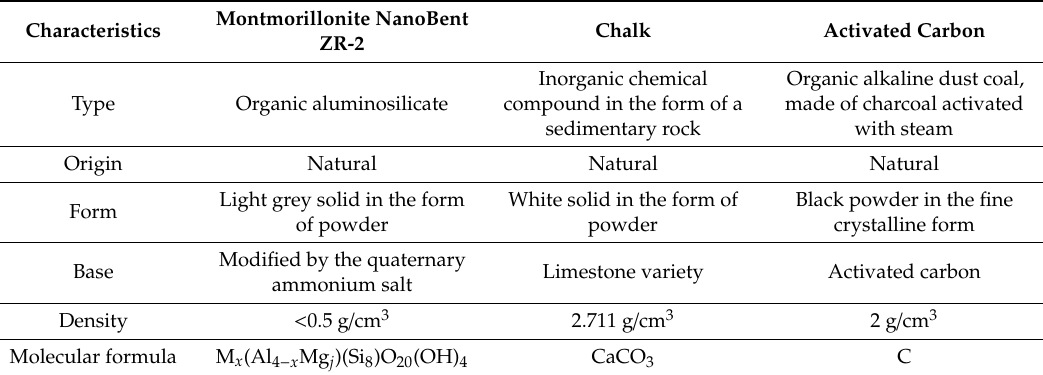
Table 3. Characteristics of fillers used in the